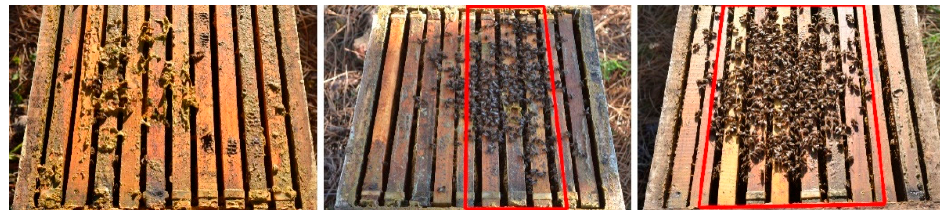
Figure 7. Visual inspection from a top view to determine the population through the count of frames full of bees (highlighted in red). Very low level of population ( Left ). Mid level of population ( Middle ). High level of population ( Right ).